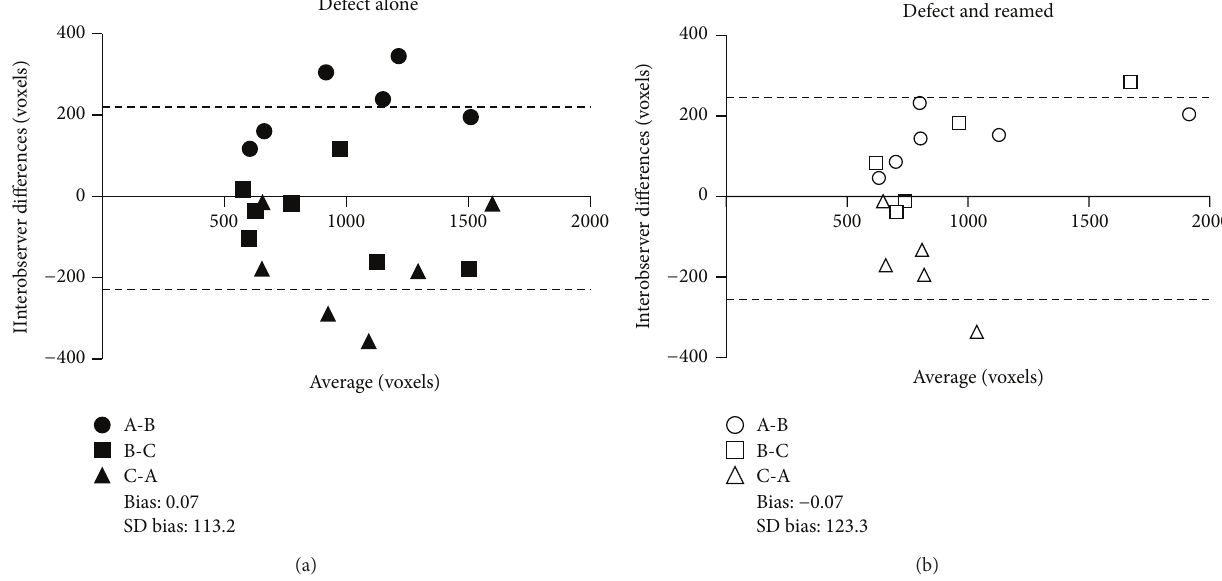
Figure2:Interobserveragreementinthedeterminationof3DROI.ABland-Altmanplotwasusedtographdifferencesintheabsolutenumber of voxels per 3D ROI as a function of the average size of the defect. This made it possible to assess the agreement between three observers in the determination of the 3D ROI. Eighteen 𝜇 CT images from (a) unreamed femurs with a defect and (b) reamed femurs with a defect were blindly analyzed. The two-by-two comparison of the three observers (A-B, B-C, and C-A) showed a 95% confidence interval from − 226.5 to +226.4 and from − 245.9 to +247.1 for unreamed femurs with a defect and reamed femurs with a defect, respectively. An interclass correlation (ICC) was used to compare interobserver variability. The ICC scores were 0.864 (very good, 𝑃 < 0.0001 ) and 0.905 (ideal, 𝑃 < 0.0001 ) for the unreamed femurs with a defect and the reamed femurs with a defect, respectively.